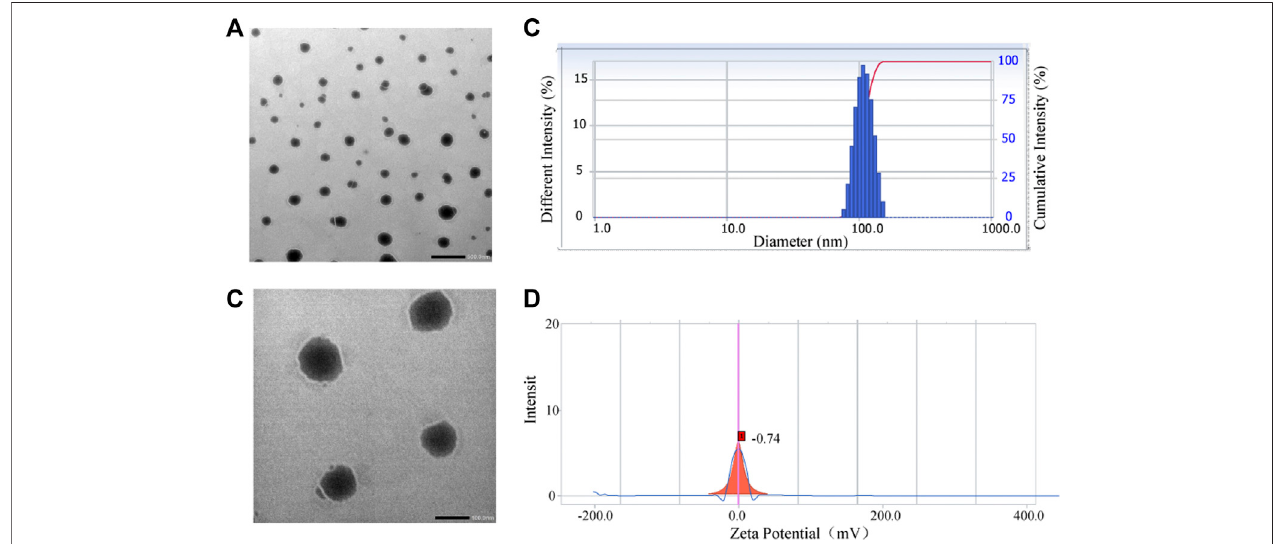
FIGURE 1 | Characterization of PSLs. Typical TEM images of PSLs (A,B) , scale bar = 500 nm (A) , scale bar = 100 nm (B) Size distribution of PSLs (C) Potential distribution of PSL (D) .